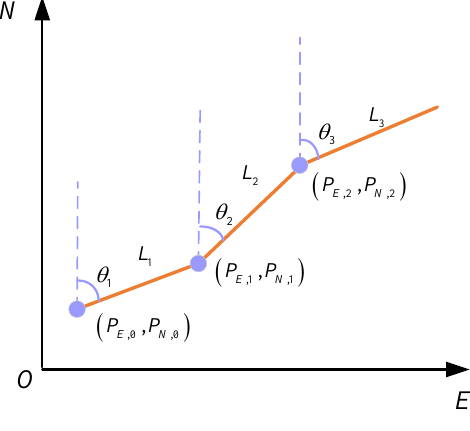
Figure 6. The schematic diagram of PDR.